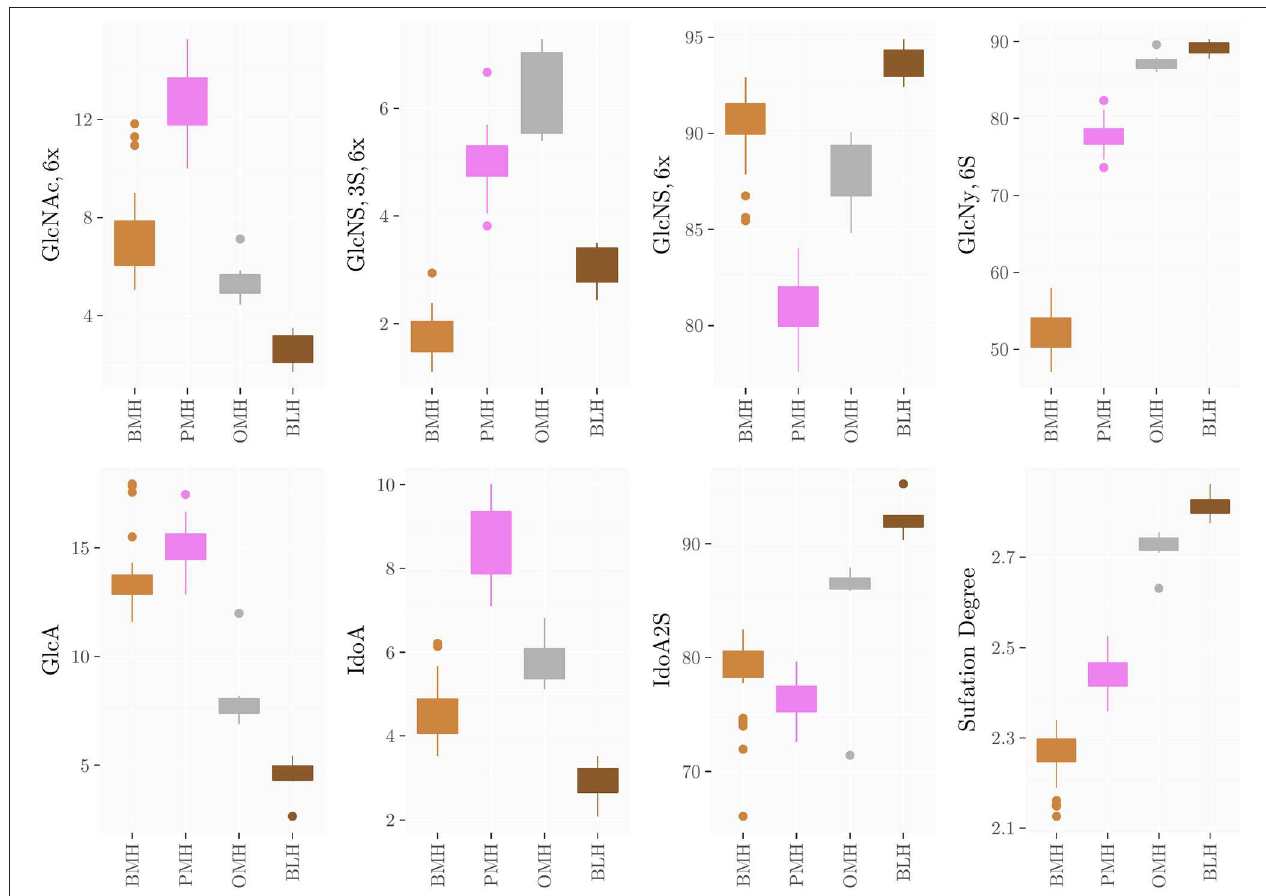
FIGURE 7 | Boxplots of the monosaccharides composition of heparins from the different sources obtained by HSQC